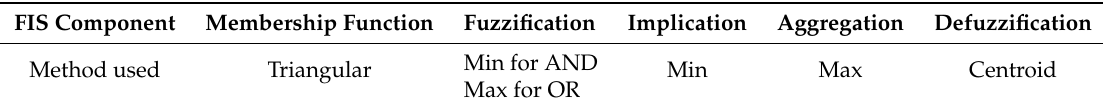
Table 3. FIS Components